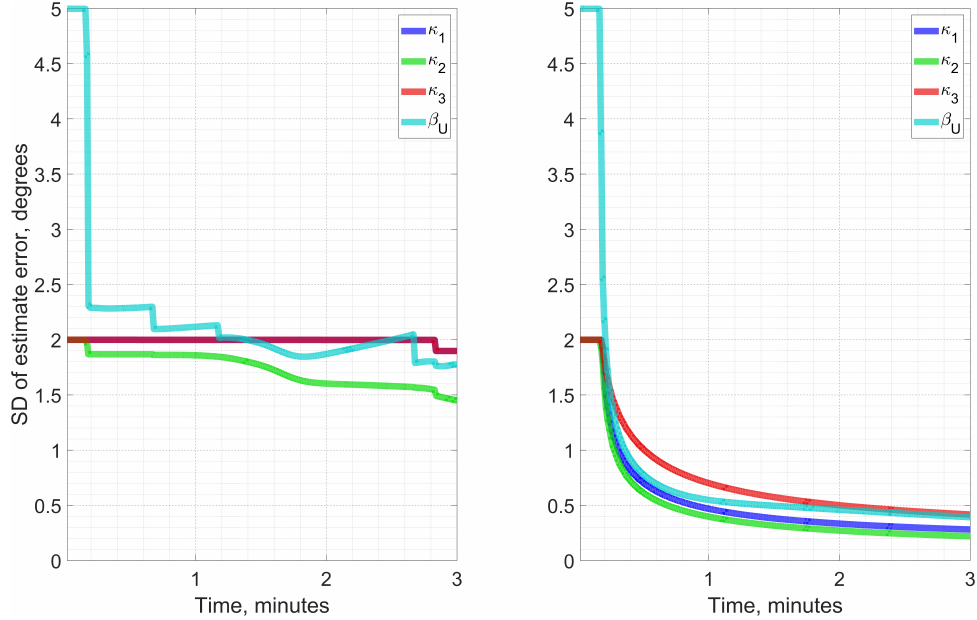
Figure 3. Estimated standard deviations (SD) for κ b , β U in two types of rotation: maytagging-like ( left ), and conical ( right ), showing the advantage of the latter one with steady convergence to lower SD values for all